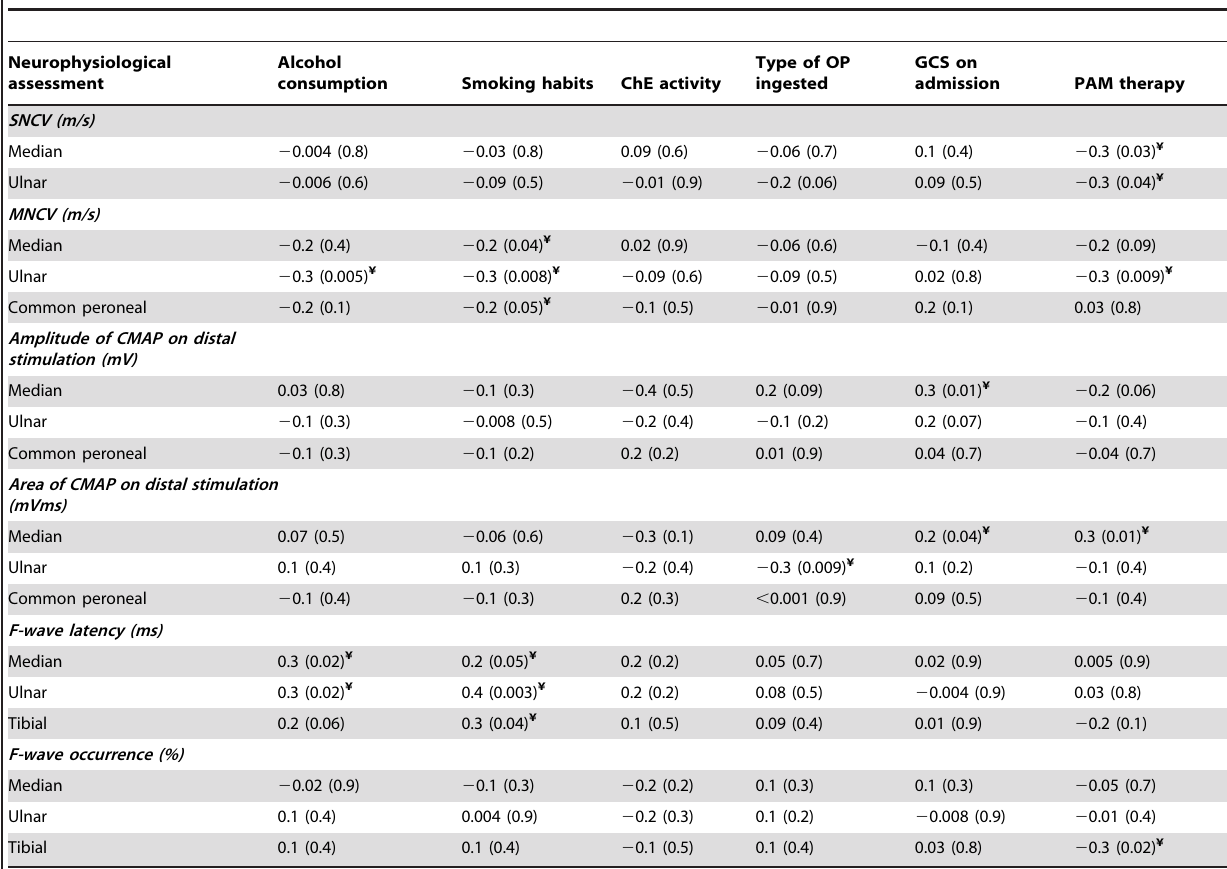
Table 5. Correlation matrix of neurophysiological indices with potential confounders. The analysis was done with Spearman’s